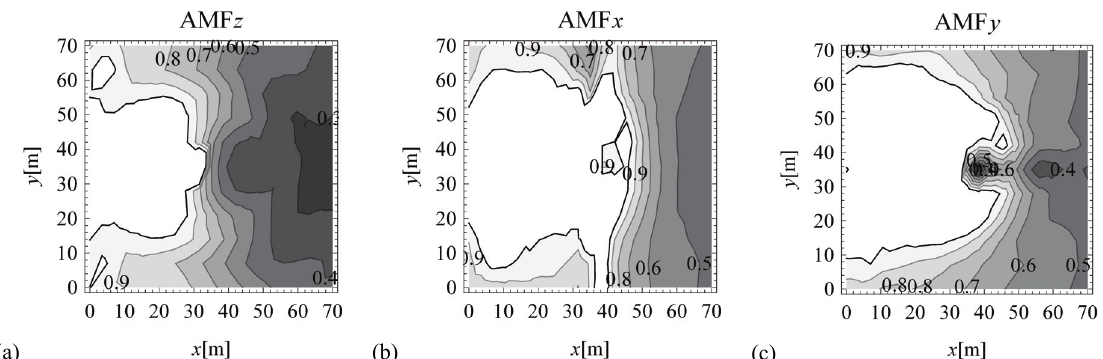
Fig. 10. AMF for the analyzed domain with the three displacement components for the points located 5 m below the ground surface, r = 2 m; plot range: 0 < AMF < 1;